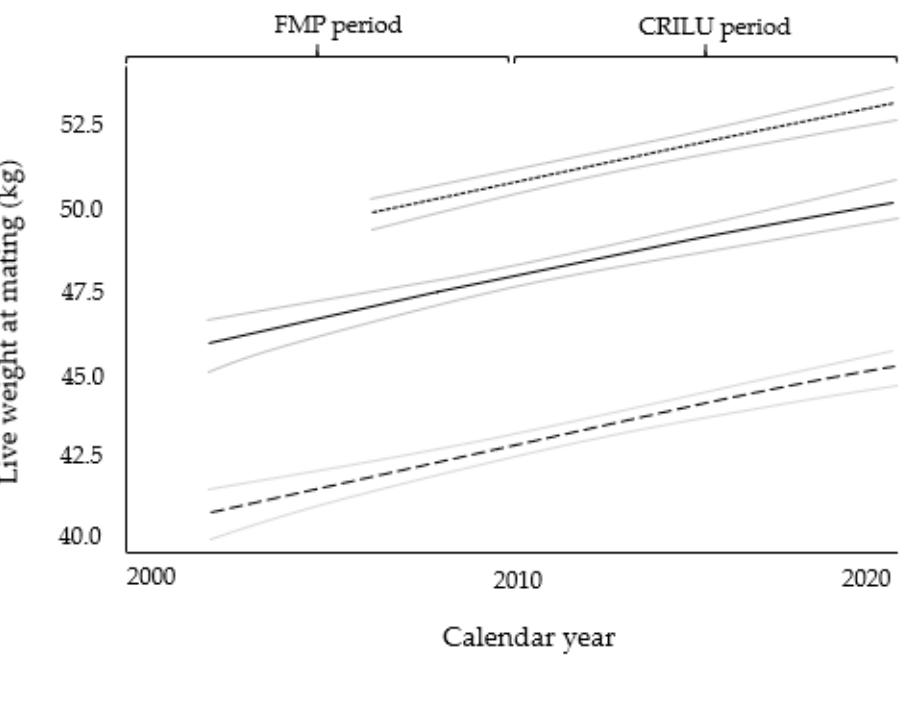
Figure 3. Two-year-old ewes, 3–6-year-old ewes, and ewes aged seven or older phenotype trends using a second-degree polynomial regression model for the average live weight at mating across calendar years (2001–2020).